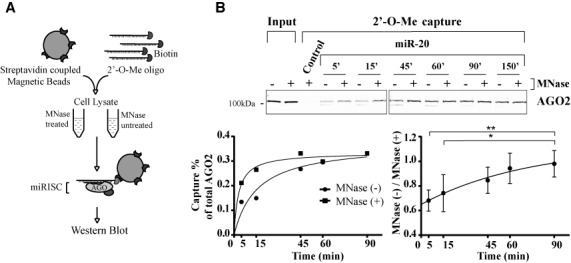
Quantitative capture of available miRISC using target site analogue oligonucleotides (2′-O-Me pull-down). (A) Schematic representation of the capture strategy. Biotinylated 2′-O-methylated (2′-O-Me) oligonucleotides encoding a binding site for a particular miRNA family (here, miR-20 and a Caenorhabditis elegans specific miRNA, miR-35 as a control) are bound to streptavidin-coupled magnetic beads and incubated for a defined time in HEK 293T protein lysates pre-treated or un-treated with MNase. Beads are pulled out, washed and western blot is performed against AGO2, a core component of miRISC. (B) Bottom left panel: quantification of the presented AGO2 western blot. Bottom right panel: aggregate quantification from four independent biological replicate experiments. Data is presented as a ratio of untreated (MNase (−)) over MNase-treated (MNase (+)). Quantitative imaging was performed using the Odyssey imaging system (LiCor). A two-tailed Student's t-test was used to calculate P-values (*: P < 0.05, **: P < 0.005).